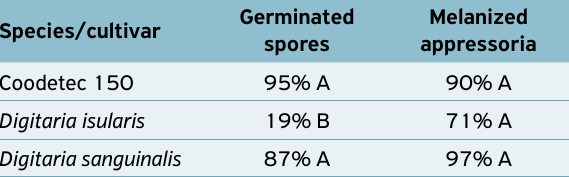
Table 1. Average percentage of Magnaporthe oryzae germinated spores and melanized appressoria 48 hours after inoculation in wheat and Digitaria plants, 2015 (Aquidauana, Mato Grosso do Sul,